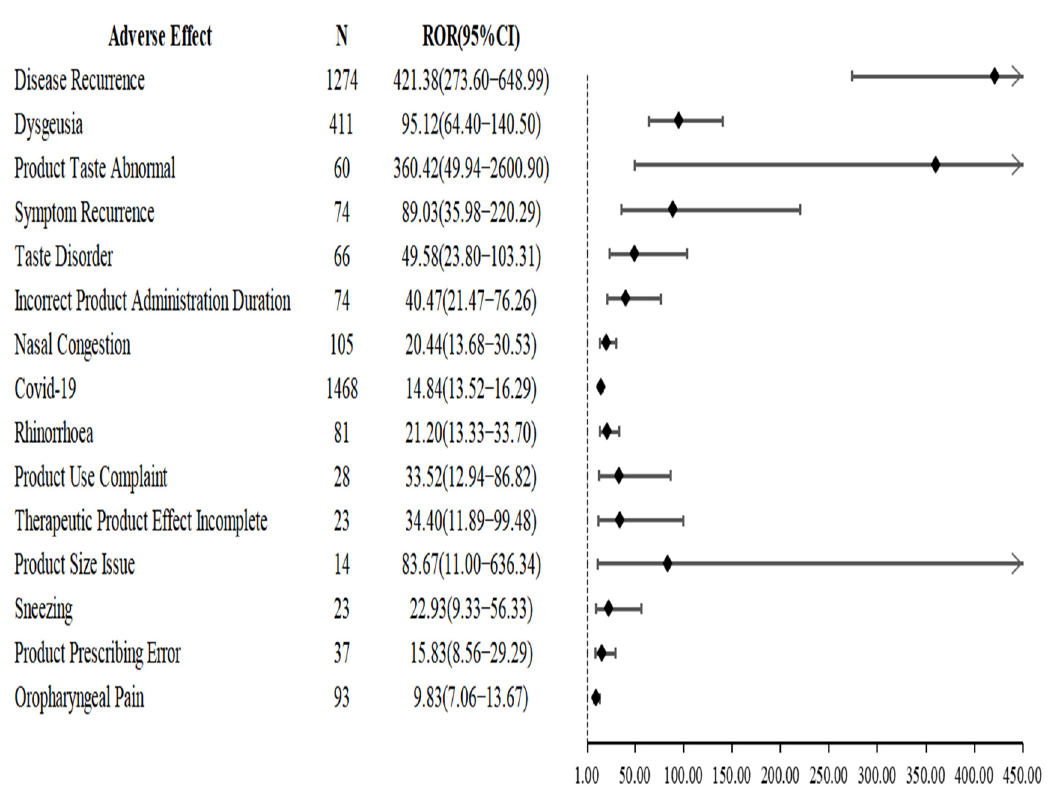
Figure 5. Results of sensitivity analysis associated with nirmatrelvir/ritonavir use.